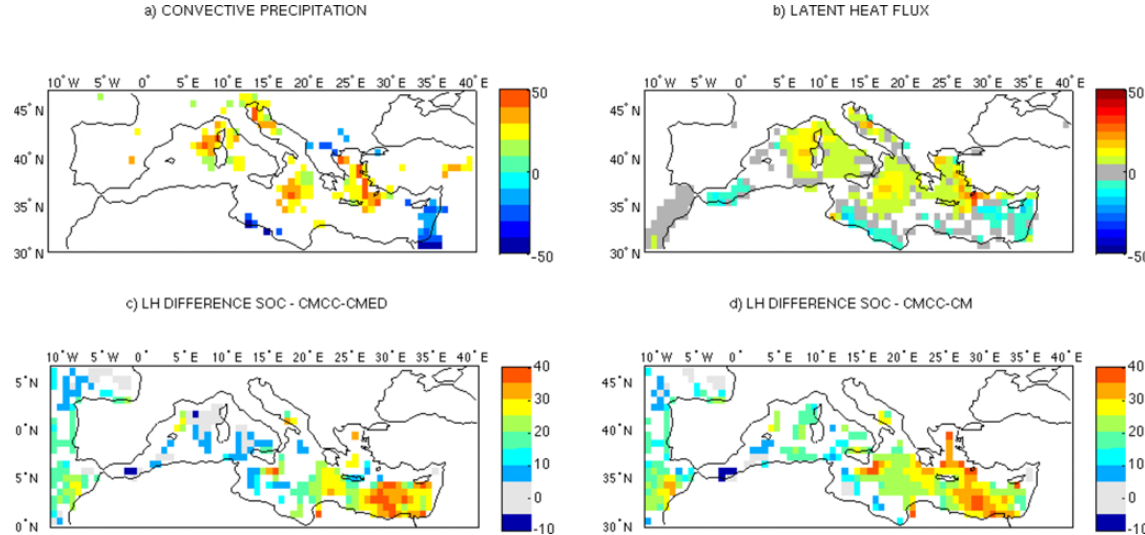
Fig. 4. Climatological differences. Panel (a) : convective precipitation. Values are expressed in percentages (CMCC-MED-CMCC- CM)/CMCC-CM. Panel (b) : surface latent heat flux (Watt/m 2 ) . Panel (c) and (d) show differences between SOC latent heat fluxes and model results (CMCC-CM and CMCC-MED respectively), over the period 1981–2005. Isolines are according to colorbars. Only statistically significant differences ( t test 95%) are shaded.